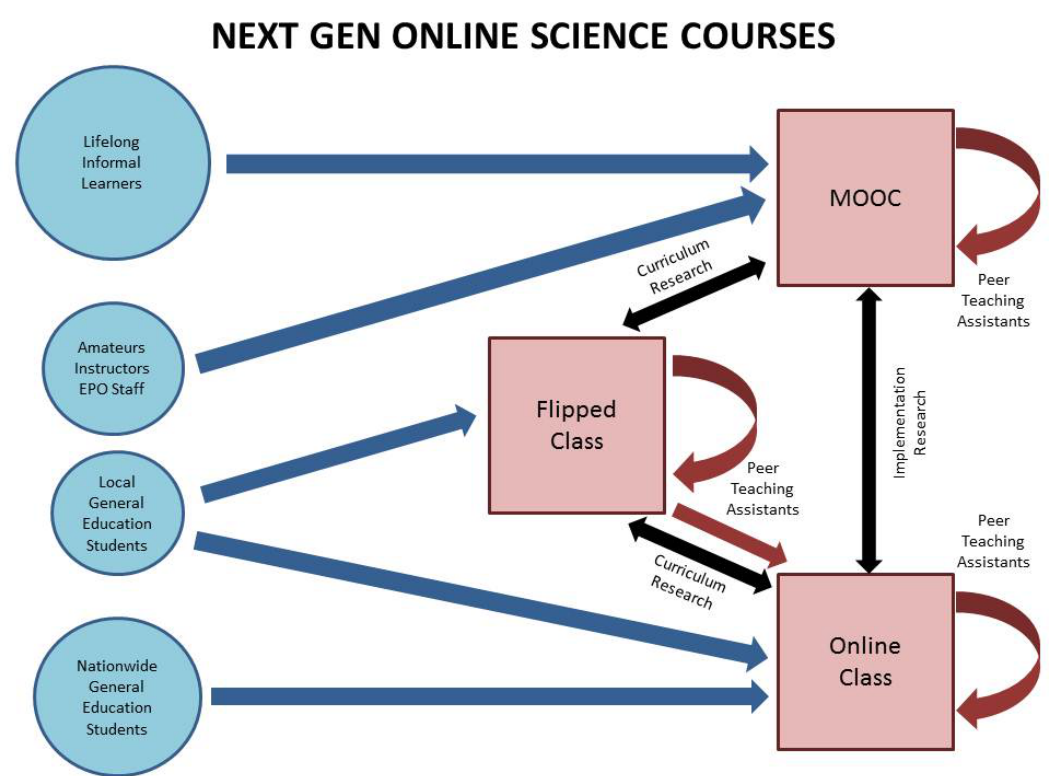
Figure 10. A schematic view of the combination of informal and formal learning that is possible when online content is used to serve both audiences. The MOOC is a purely online experience, is offered free, and is not for college credit. Meanwhile, undergraduate students needing a